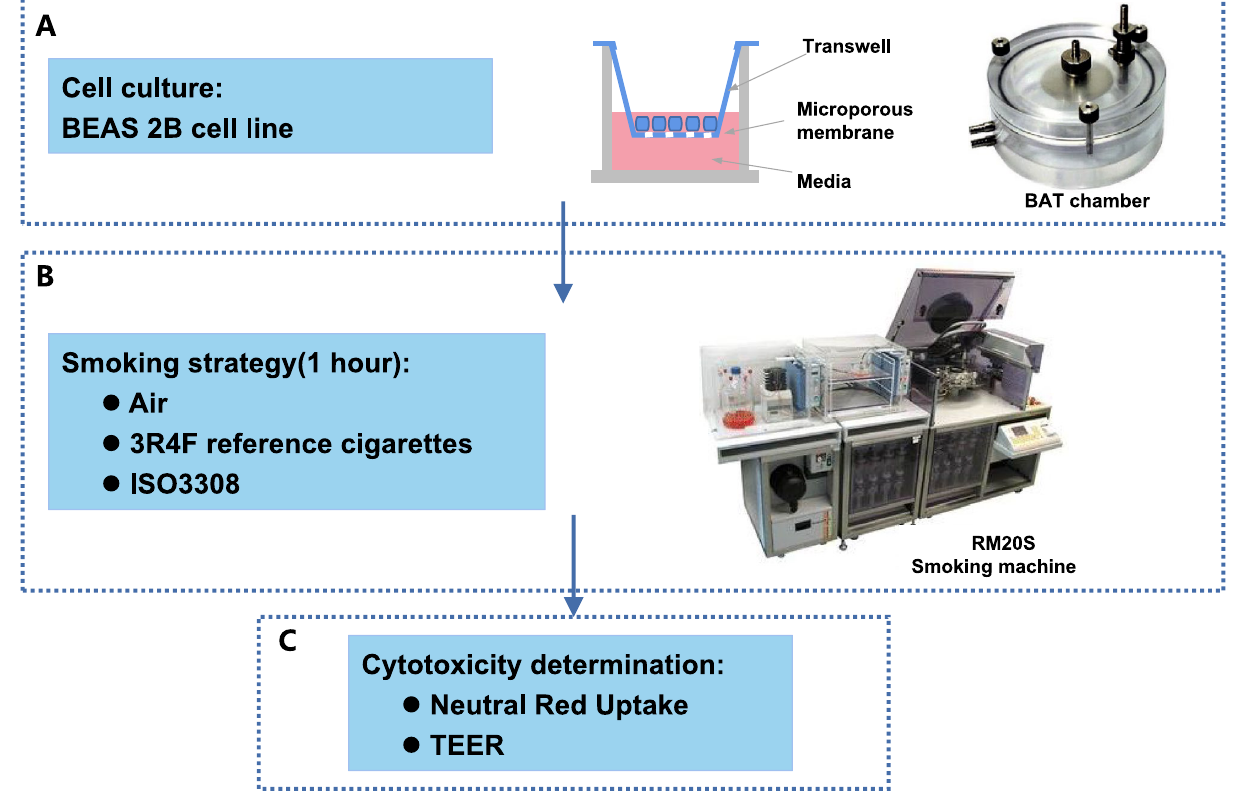
Figure 1. Experimental platform and workflow for assessment of biological impact of mainstream cigarette smoke. A BEAS 2B cells were cultured into transwells (Corning 3402) as described in the Materials& Methods. The cells were then transferred to exposure chambers for smoke exposure. B Cigarette smoke was generated in a Borgwaldt RM20S smoking machine under ISO3308 smoking regime and diluted cigarette smoke from a reference cigarette (3R4F) was introduced into cell exposure chanbers. C After treatment with the diluted cigarette smoke for 1 h, cell viability assessed by NRU assays and testing the TEER values. NRU: neutral red uptake; TEER: trans-endothelial electrical resistance. The images of Exposure chambers and Borgwaldt RM20S smoking machine are taken from Adamson et al. 52 .